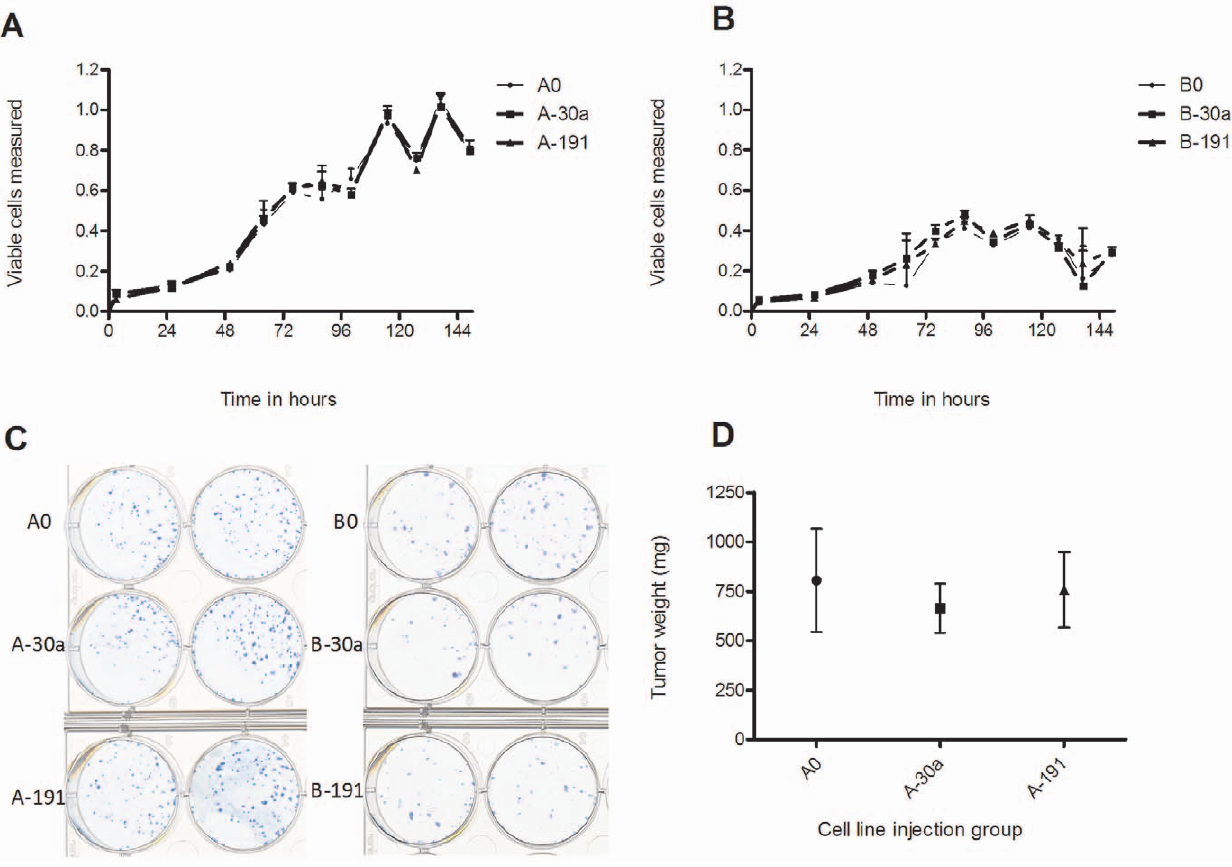
Figure 2. Overexpression of miR-30a and -191 does not alter A549 and BEAS-2B cellular proliferation in-vitro and in-vivo. A,B. Cell proliferation curves for cell lines A0, A-30a and A-191 (A) and B0, B-30a and B-191(B) demonstrating no change in cell proliferation. C. Methylene blue stained cell culture plates demonstrating no difference in adherent colony formation in A-30a and A-191 compared to A0 and in B-30a and B-191 compared to B0. D. Xenograft formation in SCID mice by A549 is not altered by over-expression of miR-30a or -191